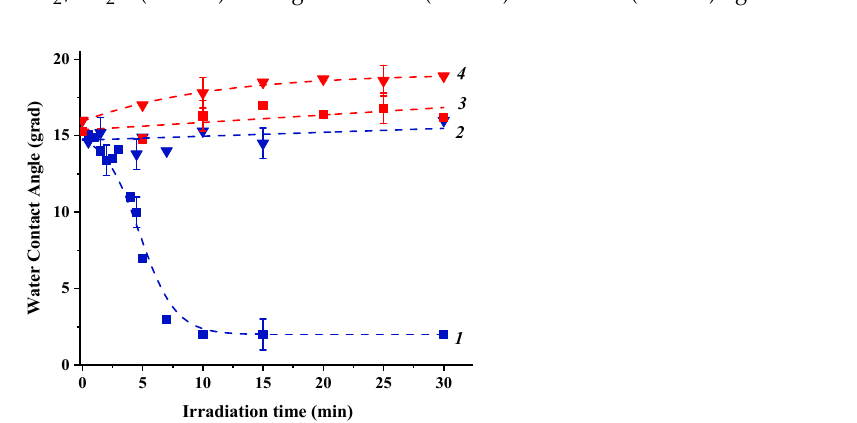
Table 4. Total (t), polar (p), and dispersive (d) surface free energies (SFE) for all coatings studied after different treatments.